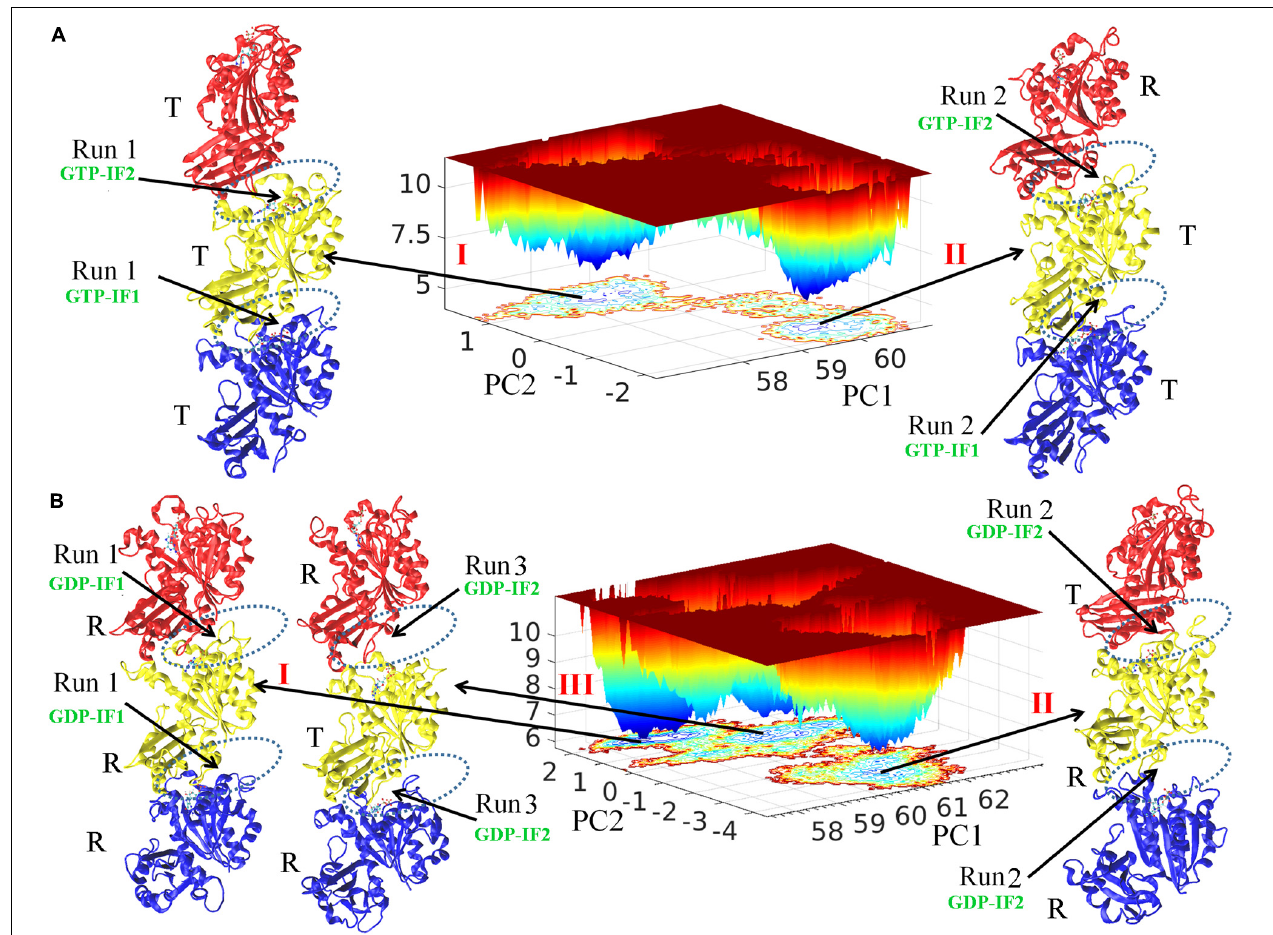
FIGURE 1 | Free energy landscape and the structural analysis. FEL plot of GTP- (A) and GDP-bound (B) trimers during whole production simulations. The final conformations from independent simulations were named I, II and III. The interfaces are indicated by dashed ellipses. The bottom, middle and top subunit are colored with blue, yellow and red, respectively. PC1 and PC2 are the first and second singular vectors obtained from SVD analysis, respectively. The z axis corresponds to free energy ( k B